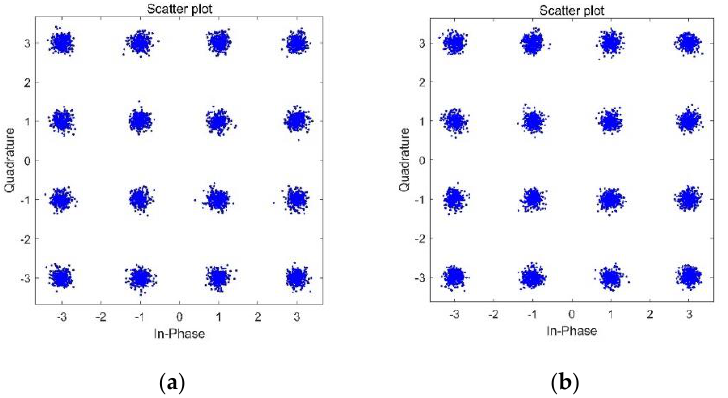
( b ) Figure 8. BPSK constellation encryption algorithm . ( a ) Phase rotation and ( b ) rotation and ampli- tude adjustment. Figure 9 is the simulation result of encrypting the BPSK constellation diagram using the random phase key and the random amplitude key at the same time. It can be seen that